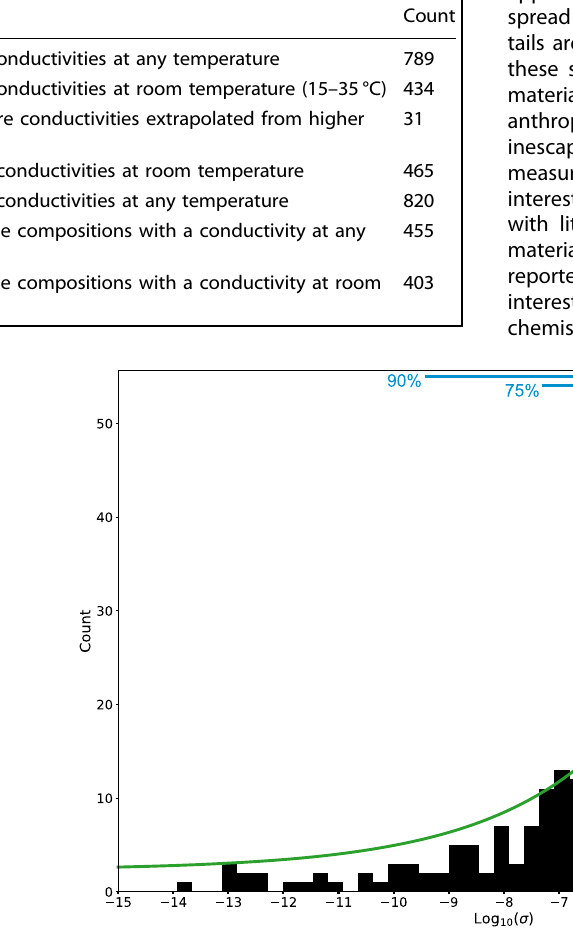
Fig. 1 Distribution in room temperature conductivities for materials in the dataset. A histogram displaying the 465 room temperature conductivities (in units of S cm – 1 ) from materials contained in this dataset and the relative distribution of their log 10 ( σ ). The mean ( x ) value of − 5.01, the median ( ~ x ) value of − 4.41, and the mode ( ^ x ) value of − 3.05 are marked on the x- axis. An asymmetric Laplace distribution has been fi t to this data, overlaid in green. The count of each bar is given on the y -axis, with the percentage of materials falling within each percentile range around the median overlaid on the top